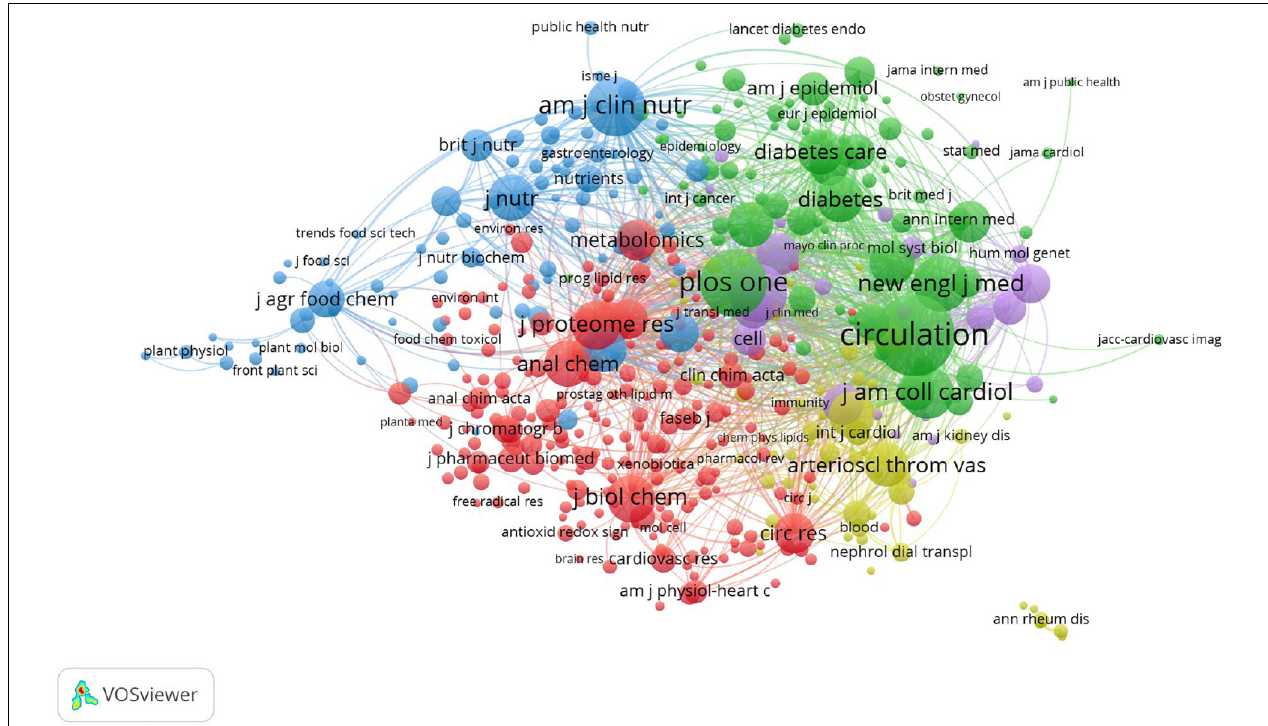
FIGURE 4 | VOSviewer visualisation map of co-citation journals devoted to coronary artery disease and metabolome research. A node represents a journal; the node with a large size represents the keyword with frequent citation. The top three co-cited journals were Circulation, PLoS One, and the American Journal of Clinical Nutrition.